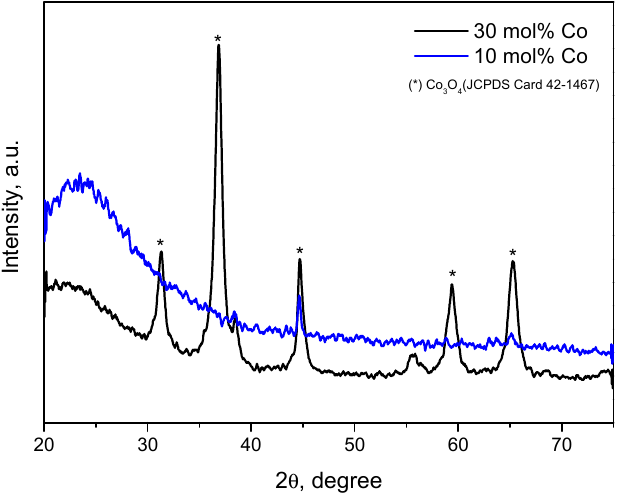
Figure 9. X-Ray Powder Diffraction (XRPD) patterns of samples CoO x -SiO 2 prepared by the hydrolytic alkoxide sol-gel route with 10 and 30 mol % of cobalt. Adapted with permission from [90].; Copyright 2018 Springer Nature.